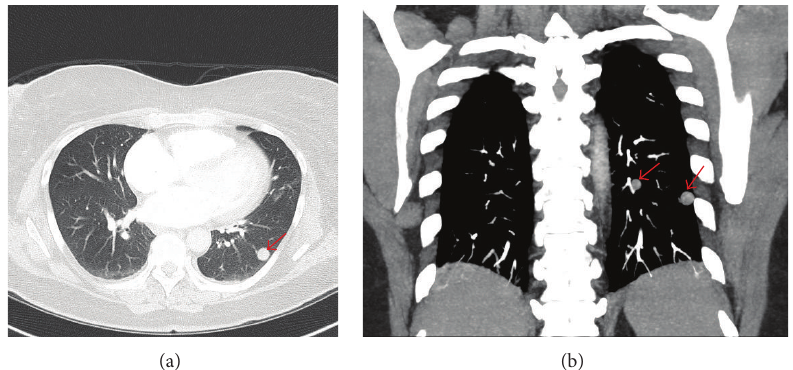
Figure 2: CT pulmonary angiogram performed the same day as the chest radiograph. (a) Axial image (lung windows): left lower lobe soft tissue nodule corresponding to the abnormality on the CXR (arrow) demonstrates no internal calcification or cavitation. Six other similar- appearing nodules of varied sizes were scattered throughout the lungs. (b) Coronal MIP image (soft tissue windows): two well-circumscribed left lower lobe nodules (arrows).